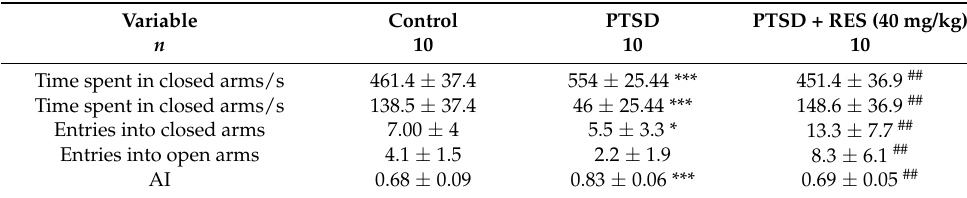
* p < 0.05, *** p < 0.001 respective, control vs. PTSD; ## p < 0.01 respective, PTSD vs. PTSD +